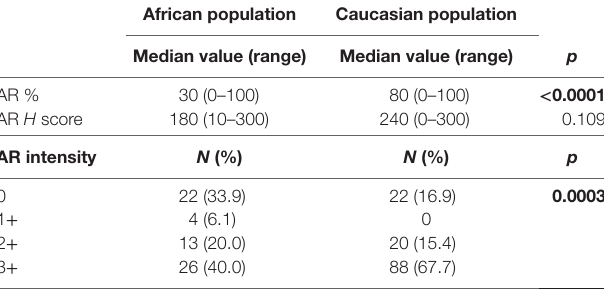
TaBle 3 | Median values of androgen receptor (AR) %, H score, and staining intensity in African and Caucasian